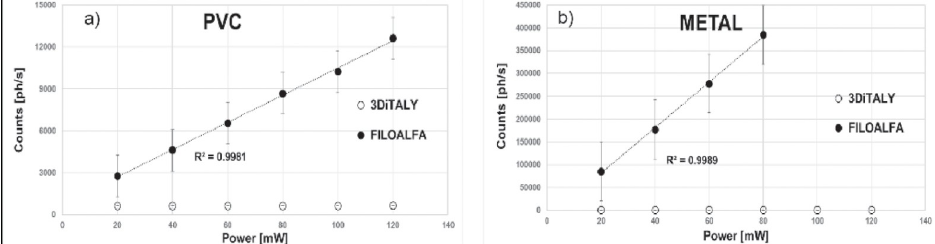
Fig 8. Photon counts obtained with the two 3D printed probes tested against a PVC (a) and METAL (b) surface. The dotted lines are the linear fit.